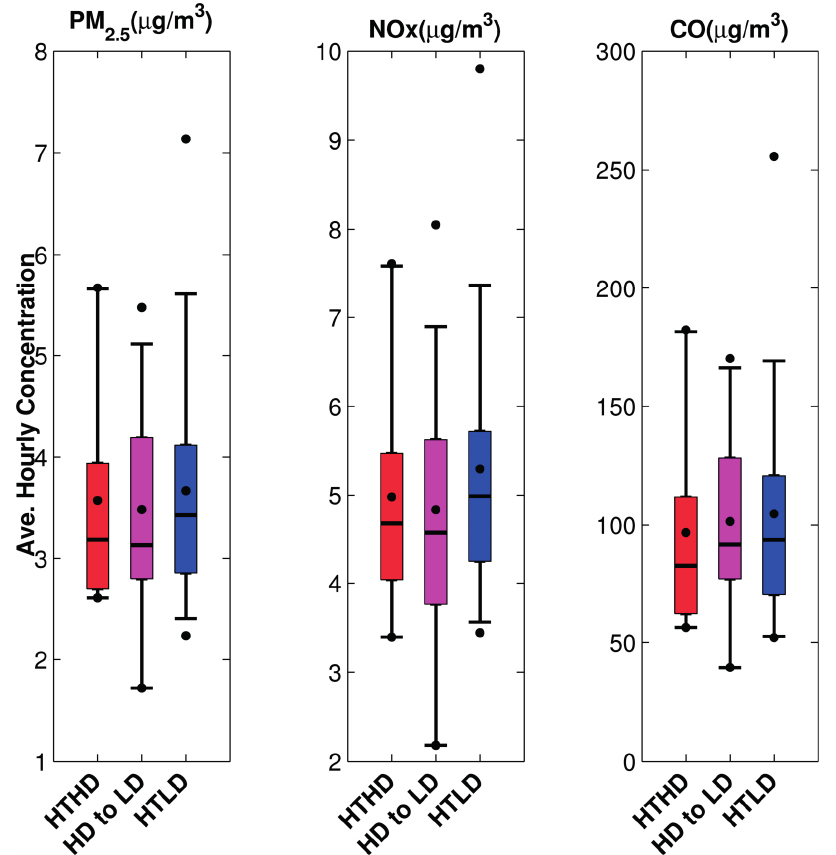
Figure 13. Temporal distributions of mobile-source component of PM the fall 2010 period after adjusting traffic volume and fleet mix used in the modeling. HT study participants whose home locations were reclassified from HD to LD are shown in magenta between the HTLD and HTLD groups.